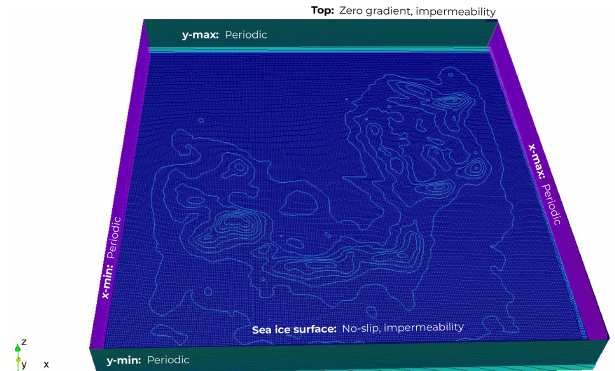
Figure 2. Boundary conditions applied at the six domain patches in the OpenFOAM snow transport simulations. Similar colors are used to represent the corresponding periodic